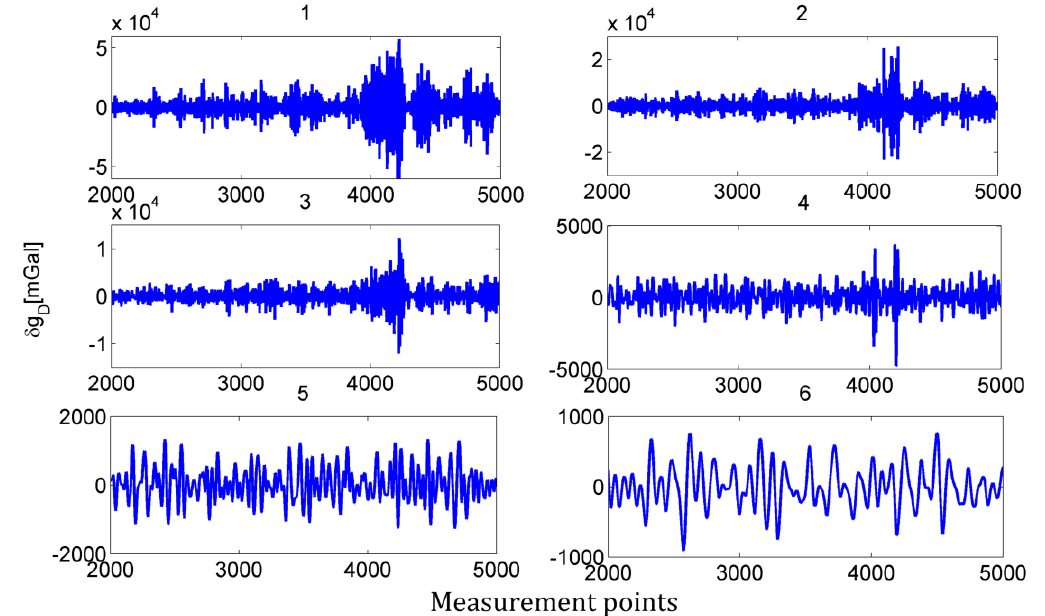
Figure 2. An example of decomposed raw data by EMD (Only the top six IMFs are shown). The left-top plot is the first IMF, and the right-bottom plot is the sixth IMF. The noise exists in all IMFs but dominates the higher frequency